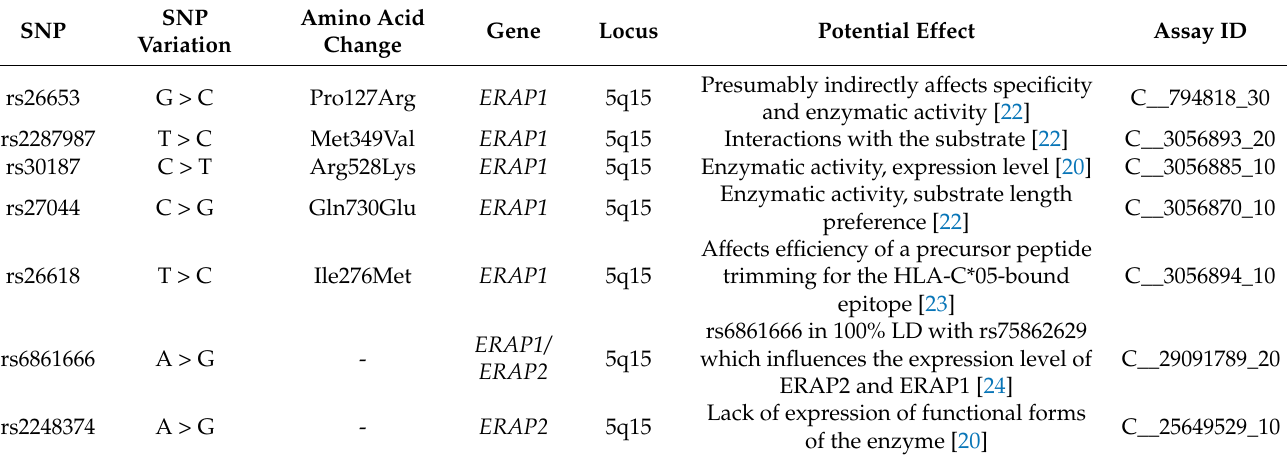
Table 3. ERAP1 and ERAP2 studied